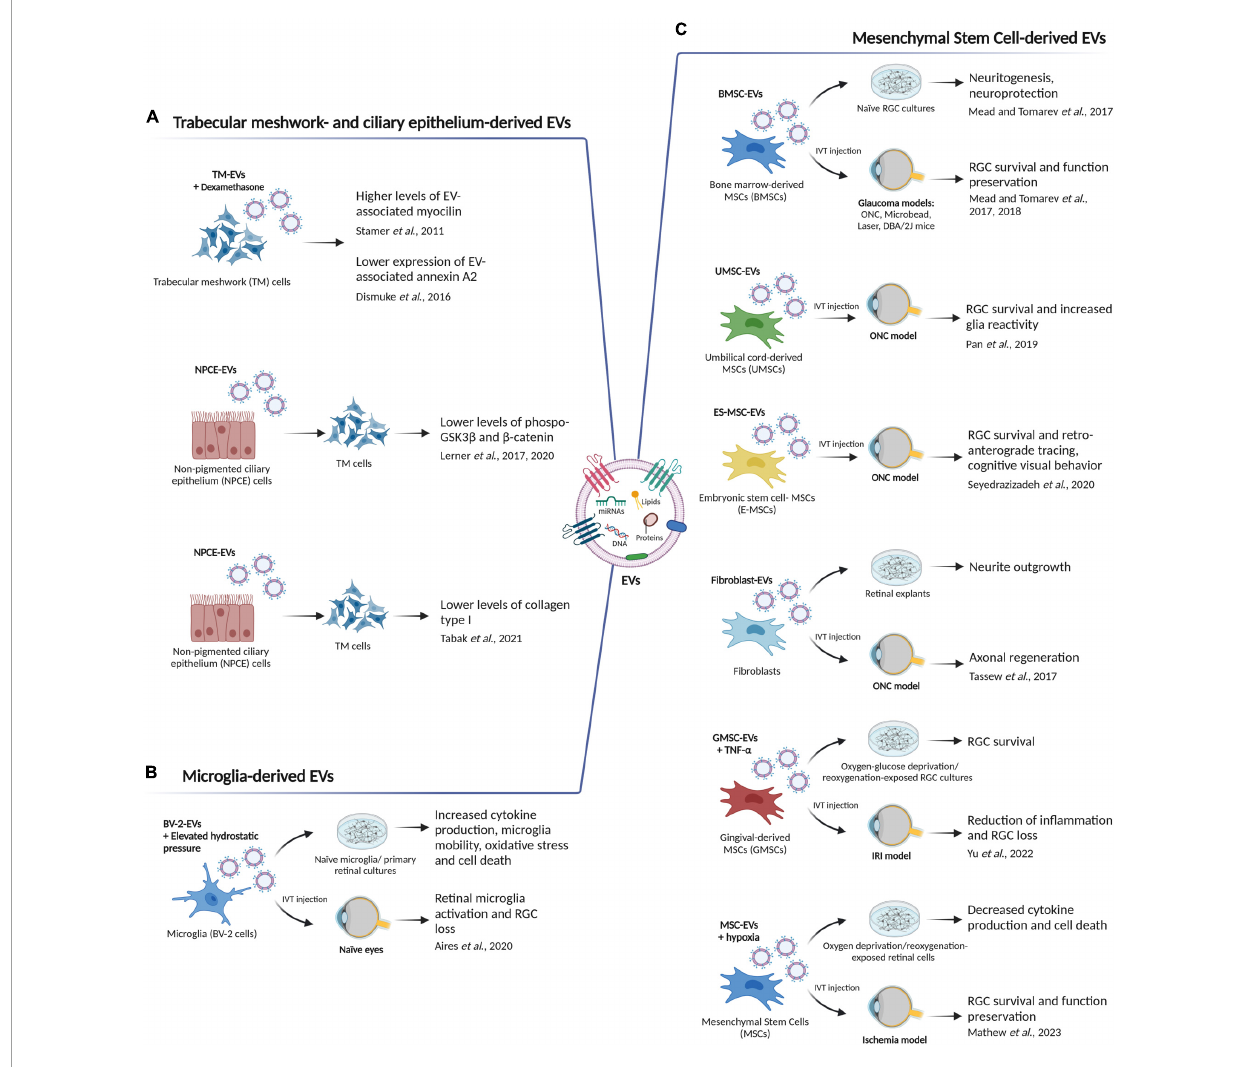
FIGURE3 The role of EVs in retinal homeostasis and glaucoma. (A) Mesenchymal stem cell-derived EVs (MSC-EVs) have been shown to improve retinal ganglion cell (RGC) survival, promote neurite outgrowth and axon regeneration, and increased glia reactivity in different in vitro and in vivo glaucoma models. ONC, optic nerve crush; IVT, intravitreal; IRI, ischemia reperfusion injury. (B) Trabecular meshwork (TM)- and non-pigmented ciliary epithelium (NPCE)-derived EVs can participate in extracellular matrix (ECM) remodeling by triggering an alteration in EV-associated myocilin and annexin A2 levels, by regulating phospho-GSK3 β and β -catenin expression and thus impinging on the Wnt signaling pathway, or by altering the formation and secretion of collagen type I. (C) Microglia-derived EVs can act as vehicles/messengers to increase cytokine production,